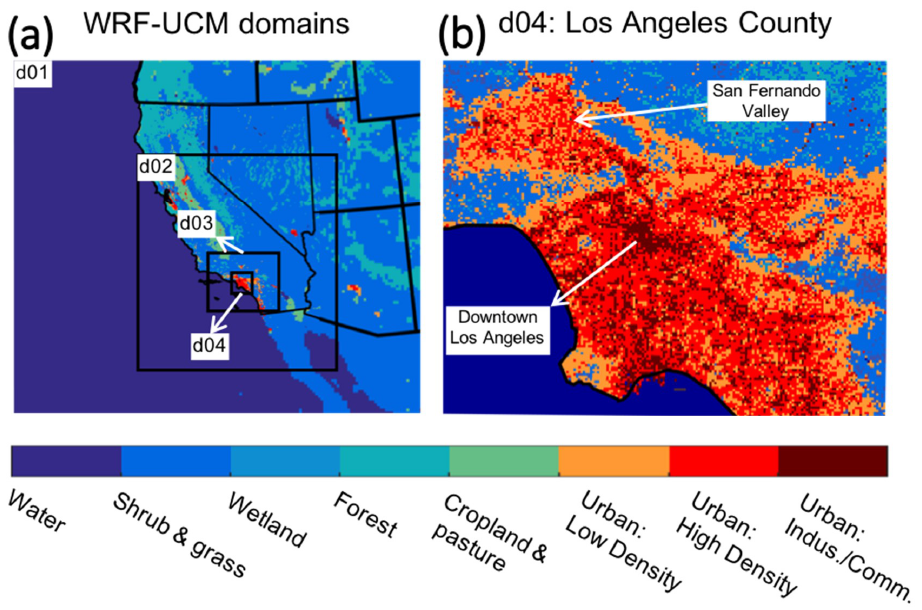
Figure 1. WRF-UCM domain configuration: ( a ) four nested domains with horizontal resolutions of 13.5, 4.5, 1.5, and 0.5 km for d01, d02, d03, and d04, respectively; ( b ) the innermost domain (d04), covering urban Los Angeles county with a 500 m resolution.